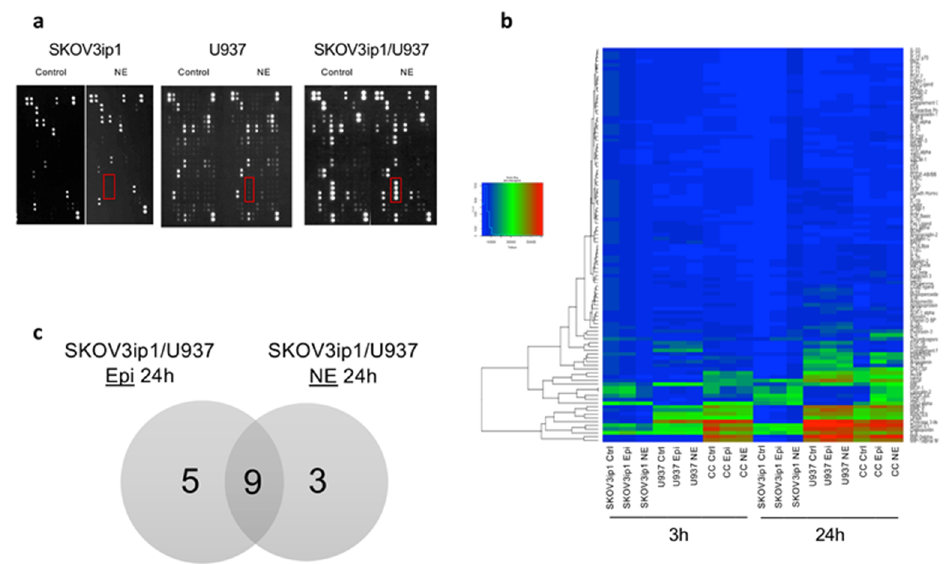
Figure 1. Adrenergic stimuli modulate ovarian cancer cells/macrophage co-cultures cytokine networks. ( a ) Cytokine arrays from SKOV3ip1 and U937 cell lines in monocultures and co-culture conditions 24 hrs after 10 μM NE exposure. Dots represent cytokines, and red boxes show how changes in cytokine expression are seen in films. Red box demonstrating changes in MIP-1 alpha/beta and MIP-3alpha. ( b ) Heatmap of differentially expressed cytokines between ovarian cancer cells, macrophage monocultures, and co-cultures. The degree of expression is indicated by different colors. Blue, low expression; green, medium expression; red, high expression. Heatmap shows mean raw expression values. ( c ) Venn Diagram of upregulated cytokines shared between epinephrine (Epi)- and norepinephrine (NE)-treated co-culture systems.